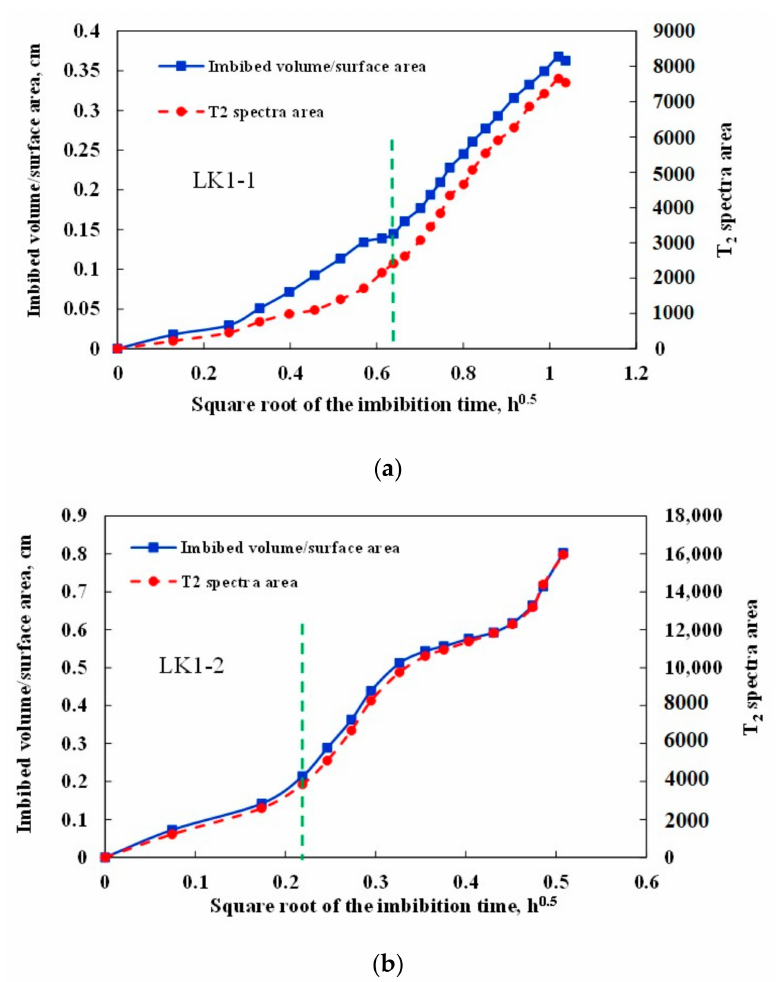
Figure 8. Imbibition volume / sectional area and spectra area vs. square root of time in LK formation.